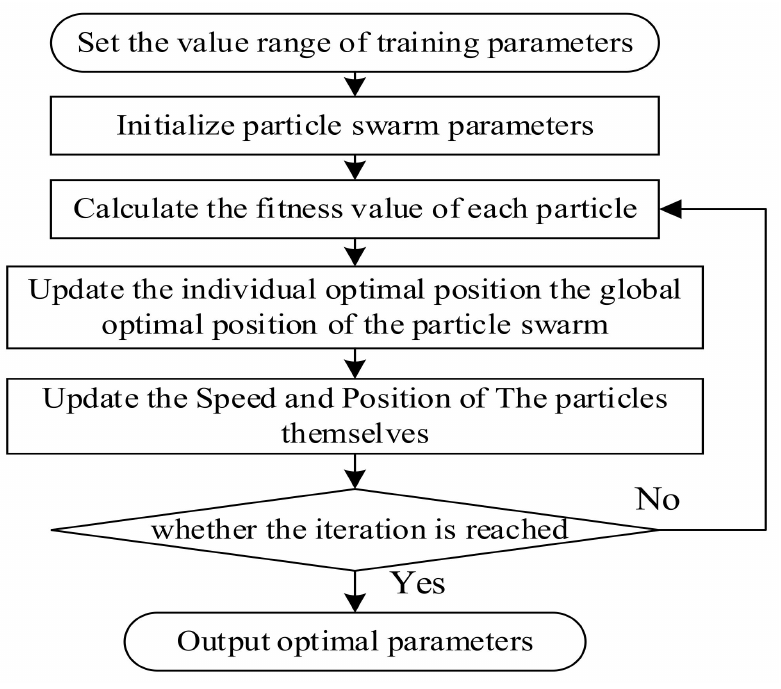
Figure 2. Parameter optimization